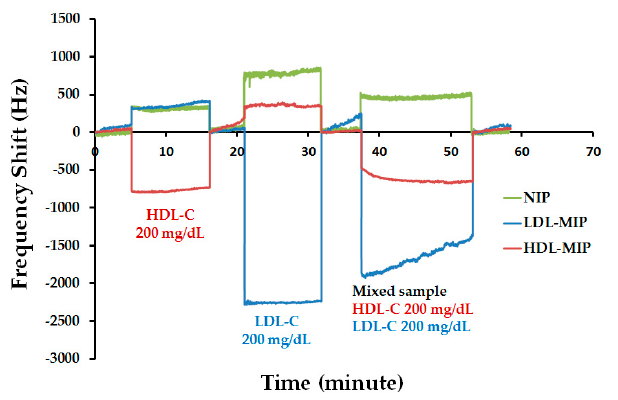
Figure 2. QCM responses toward standard HDL-C, LDL-C and mixed-LDL-C and HDL-C in 10 mM PBS.